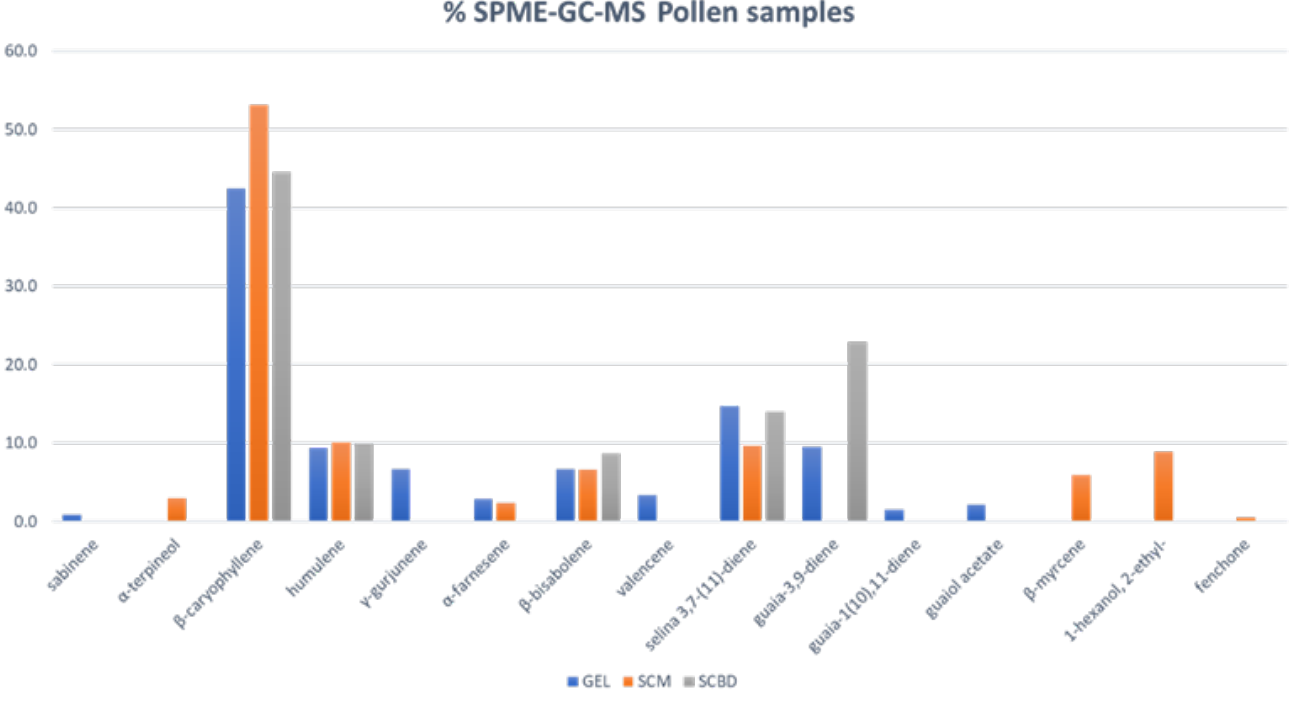
Figure 1. Chemical volatile percentage composition of GEL, SMC, and SCBD of C. sativa pollen sam- ples.